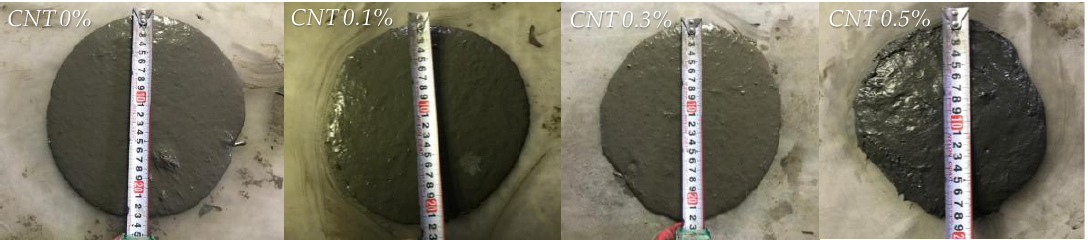
Figure 6. Flow table test results.